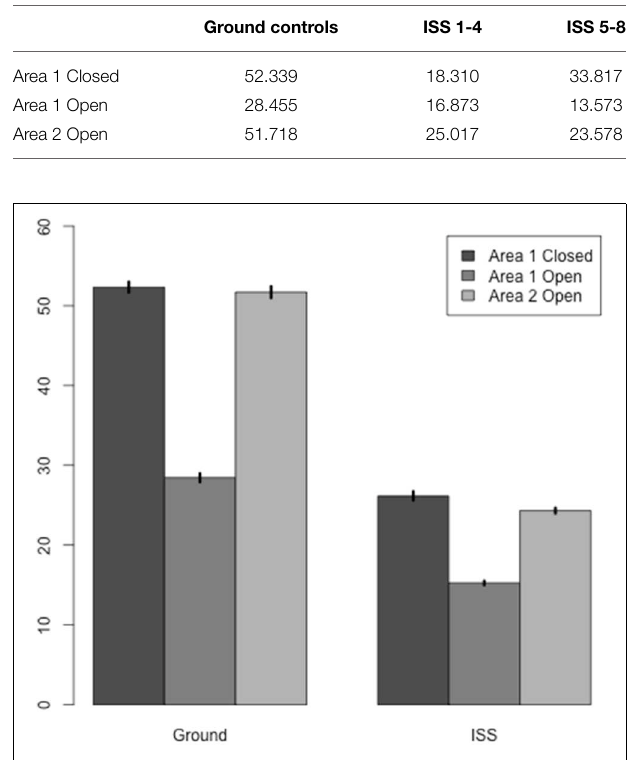
FIGURE 5 | Change in thoroughness of search when the search area expanded. Each bar shows the mean number of ants per large grid square (9.2 by 9.2mm). Dark, Area 1 with barrier closed; Medium, Area 1 with barrier open; Light gray, Area 2 after barrier was opened. TABLE 2 | Results of linear mixed effect model of mean number of ants per square against Area and treatment (ISS or ground controls), with replicates serving as a random effect.